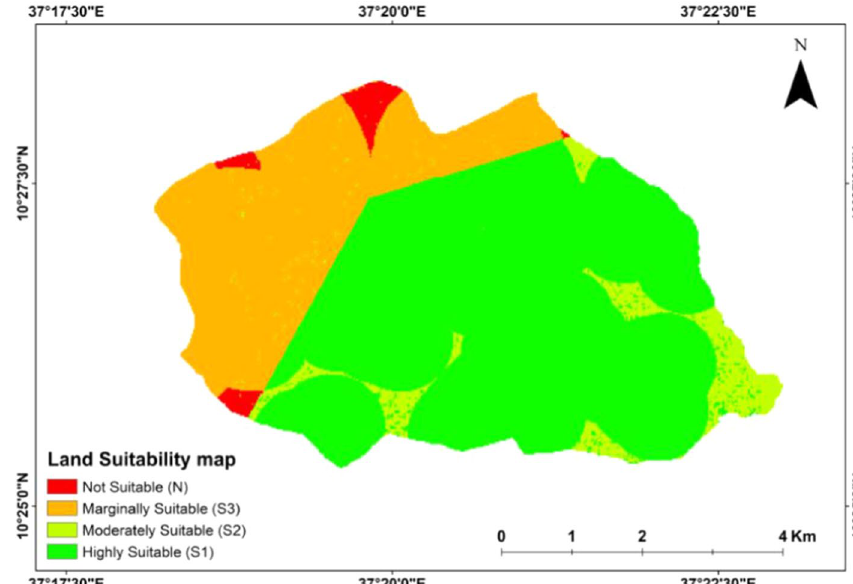
Fig. 4 Land suitability map